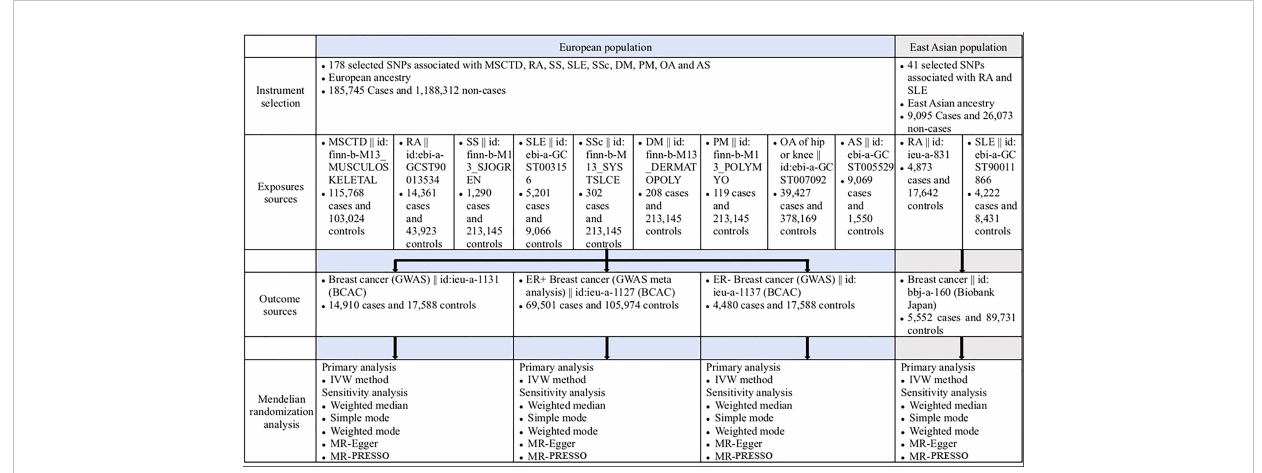
FIGURE 1 Overview of the study design (European population and East Asian population). AS, ankylosing spondylitis; BCAC, Breast Cancer Association Consortium; DM, dermatomyositis; IVW, inverse variance weighted; MR-PRESSO, Mendelian randomization pleiotropy residual sum and outlier; MSCTD, diseases of the musculoskeletal system and connective tissue; OA, osteoarthritis; PM, polymyositis; RA, rheumatoid arthritis; SLE, systemic lupus erythematosus; SNP, singlenucleotide polymorphism; SSc, systemic sclerosis; SS, Sjogren